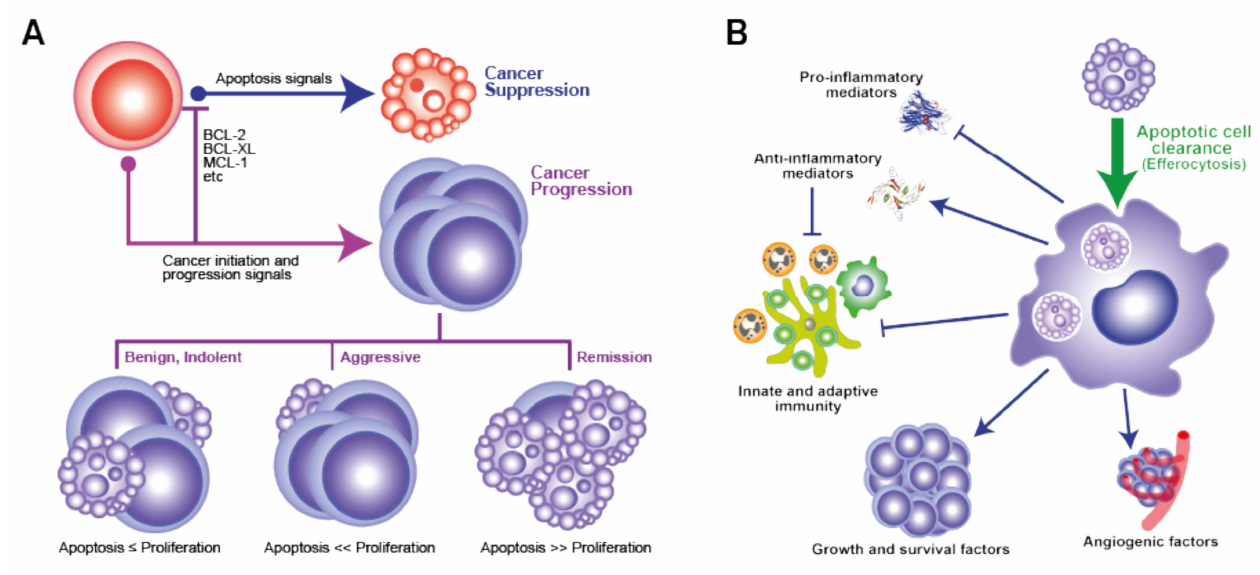
Figure 1. The ‘apoptosis paradox’ in malignant disease ( A ): Apoptosis as a cell-autonomous process is tumour-suppressive (top, blue arrow). Protection from apoptosis (e.g., by anti-apoptotic BCL-2 family members) permits survival of mutant cells and outgrowth of premalignant or malignant populations. Fractional apoptosis within these populations, dependent upon the relative levels of proliferating and dying cells, yields different growth rates. Therapeutic efficacy is achieved when cell death exceeds cell birth (remission, bottom right). ( B ): The best-known functional programmes of phagocytes (especially macrophages) engaging in efferocytosis. All have pro-oncogenic features. Note that immune responses (shown here as suppressed) may also be stimulated by apoptotic cells in certain